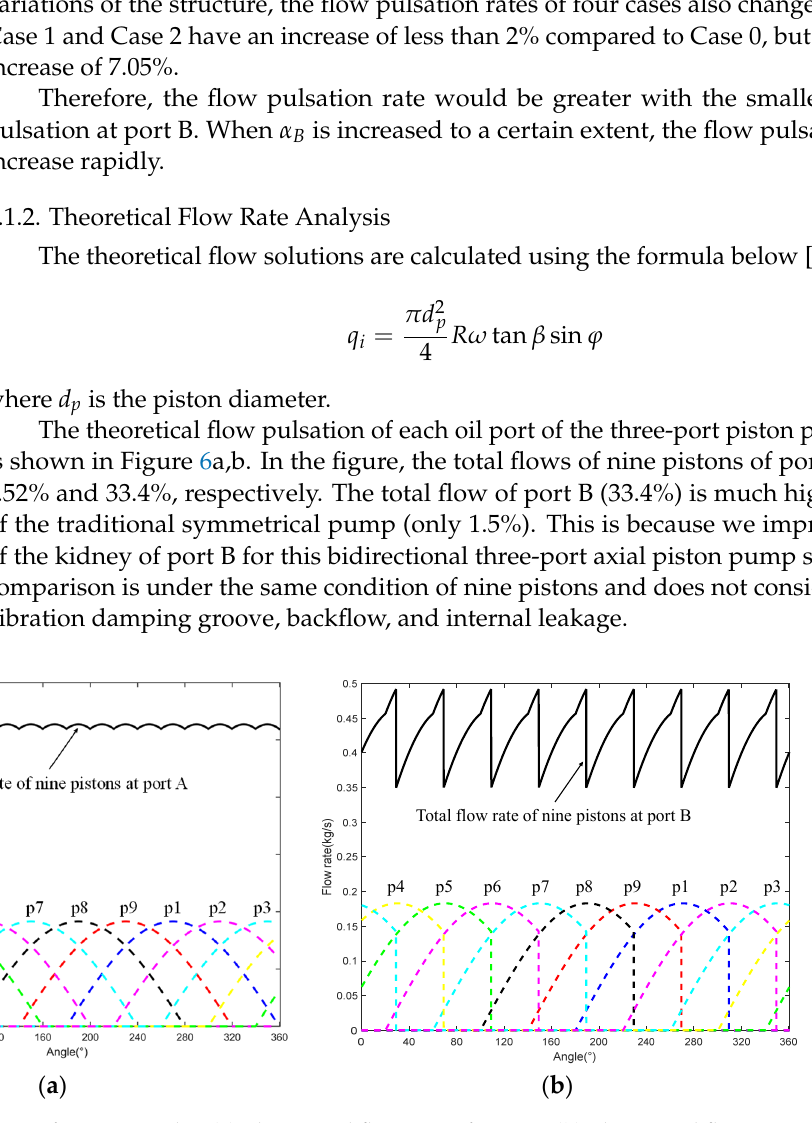
Figure 6. Theoretical flow rate of ports A and B. ( a ) Theoretical flow rate of port A. ( b ) Theoretical flow rate of port B.